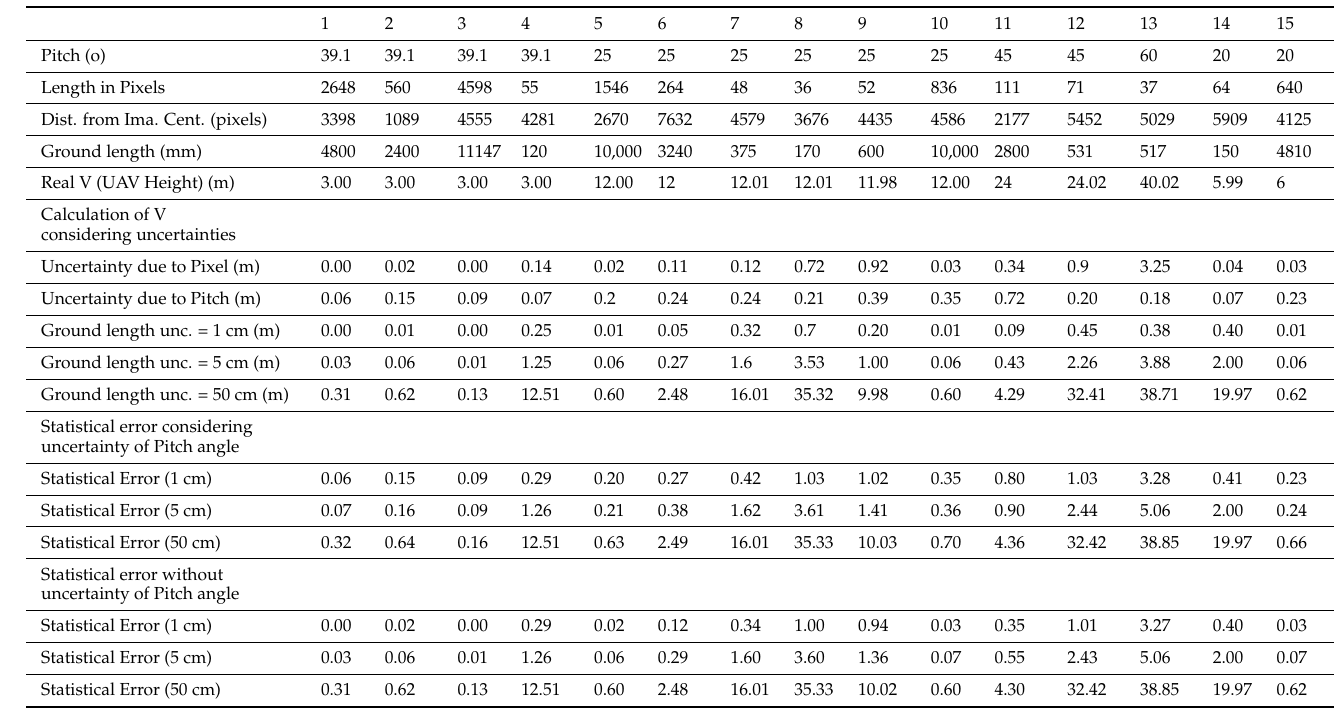
Table 1. 15 cases with different orientation, distance from the center, and ground lengths were created considering consumer-level UAVs, such as DJI Phantom 4 PRO. These cases (artificially created)